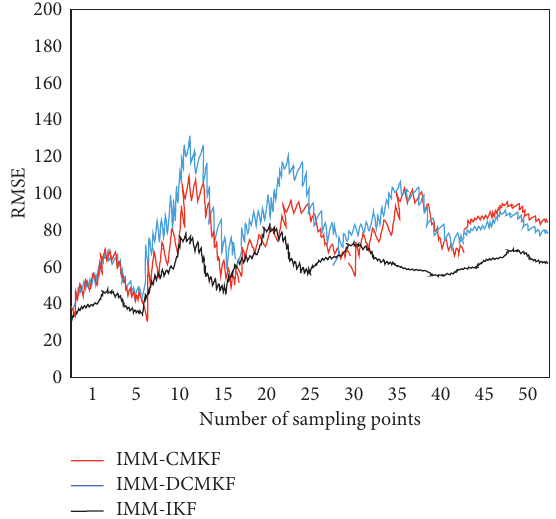
Figure 8: Normalized estimation variance comparison.